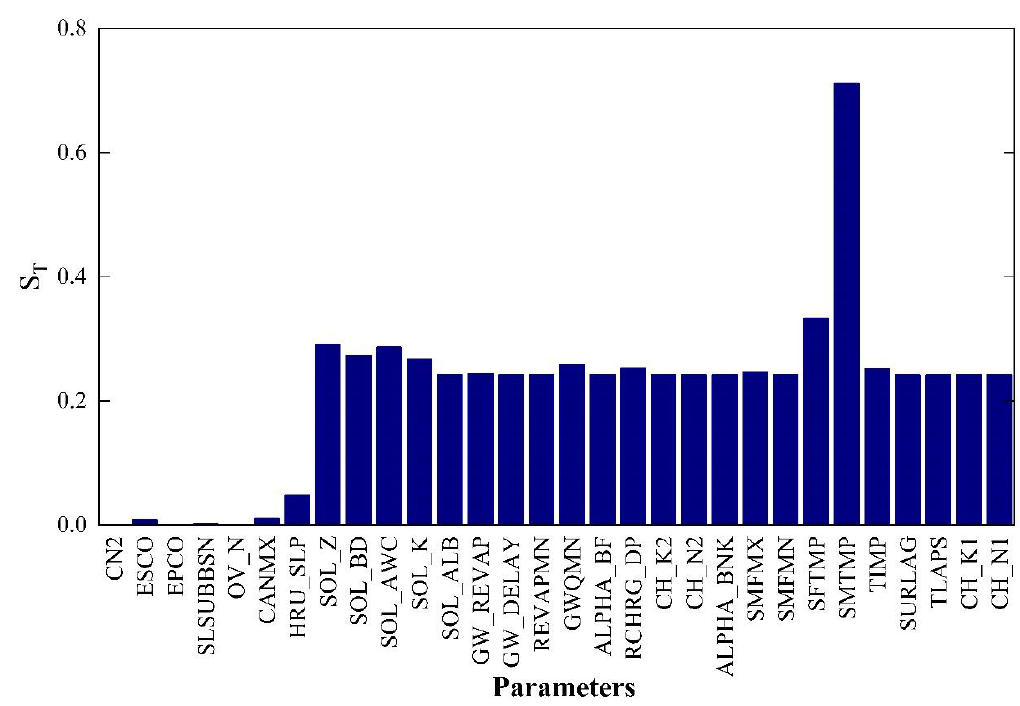
Figure 8. Total sensitivity ( 𝑆 𝑇 ) of each parameter of Sobol analysis.